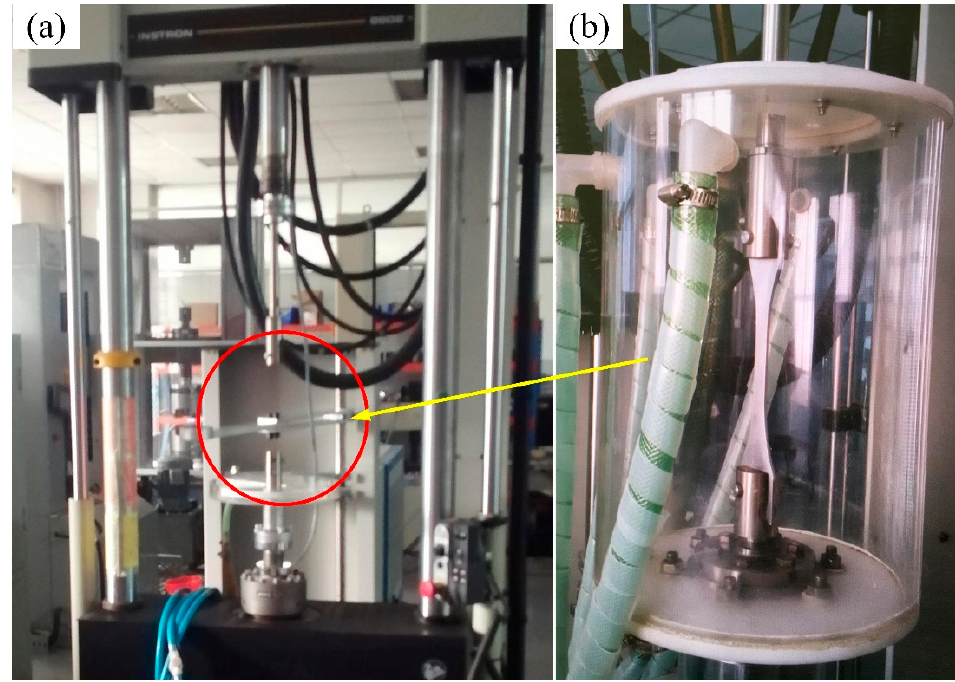
Figure 2. Setup for corrosion fatigue test: ( a ) MTS-LPS-204 universal testing machine; ( b ) box to provide corrosion experiment.